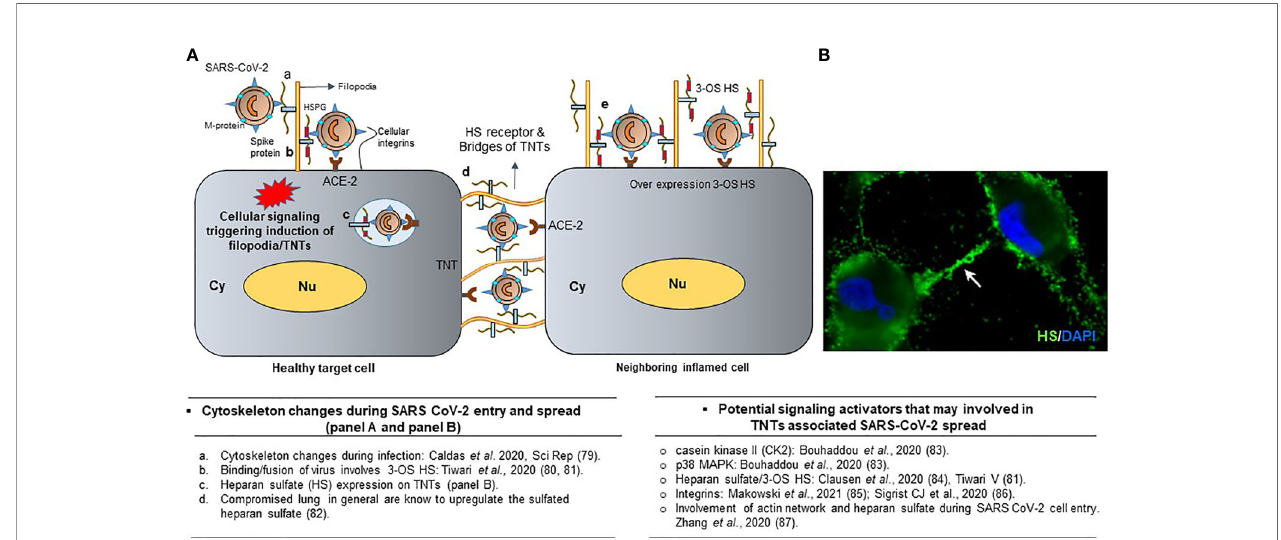
FIGURE 6 | Signi fi cance of TNTs during SARS-CoV-2 infections. (A) Cellular signaling leads to the heparan sulfate (HS) rich projections in the form of fi lopodia which facilitates viral entry. Presence of viruses on TNTs bridges during spread. Overexpression of heparan sulfate and chemokine in the in fl amed cells are shown. (B) Surface expression of HS receptor (green) on the TNT bridges using anti-HS antibodies (US biological) along with the DAPI stained nucleus is shown. Finally, the literature associated with the cell signaling during the activation of cellular protrusions during SARS CoV-2 infections are